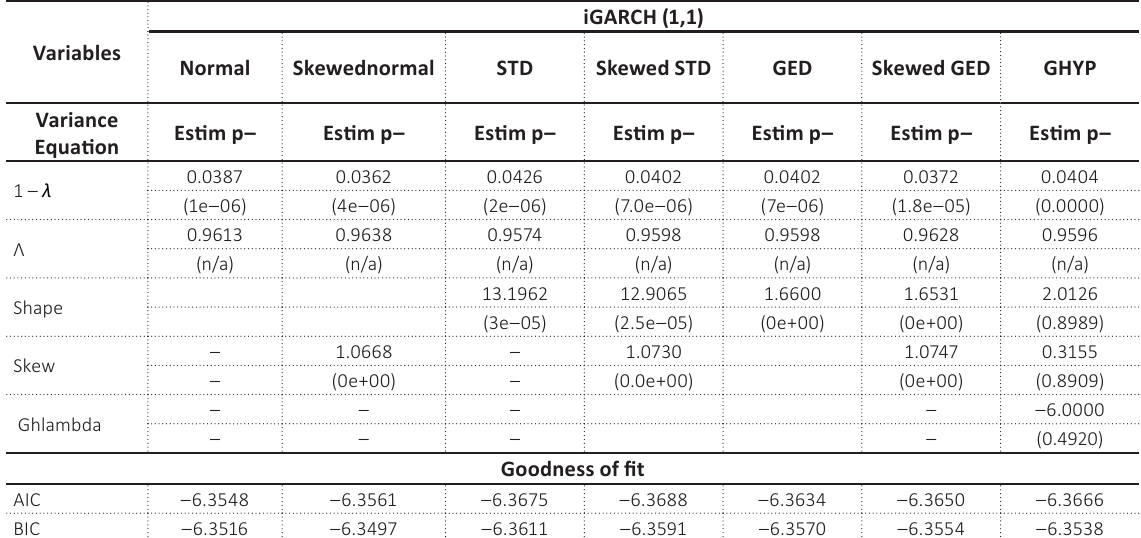
Table 4. Optimal RiskMetrics parameter estimates for